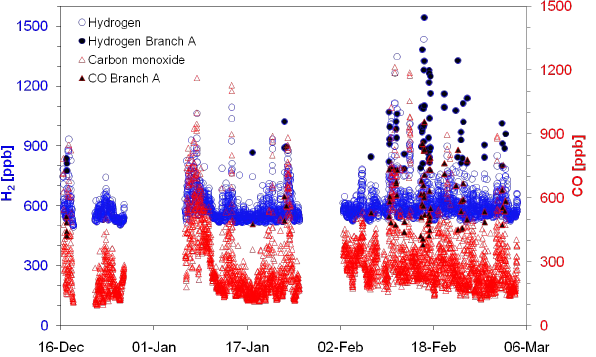
Fig. 3. H 2 and CO mole fractions and wind speed over a six day period in January 2009, with rush hours highlighted in yellow for morning and green for